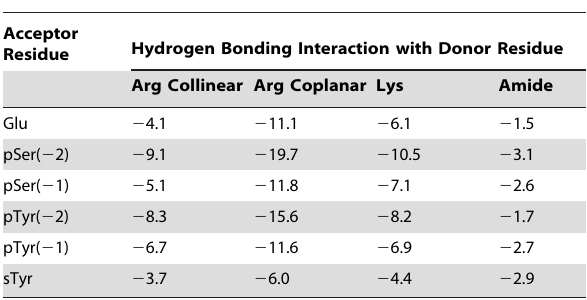
Table 3. Characterization of Hydrogen Bonds to Glu, pSer, pTyr, and sTyr in Experimental Protein